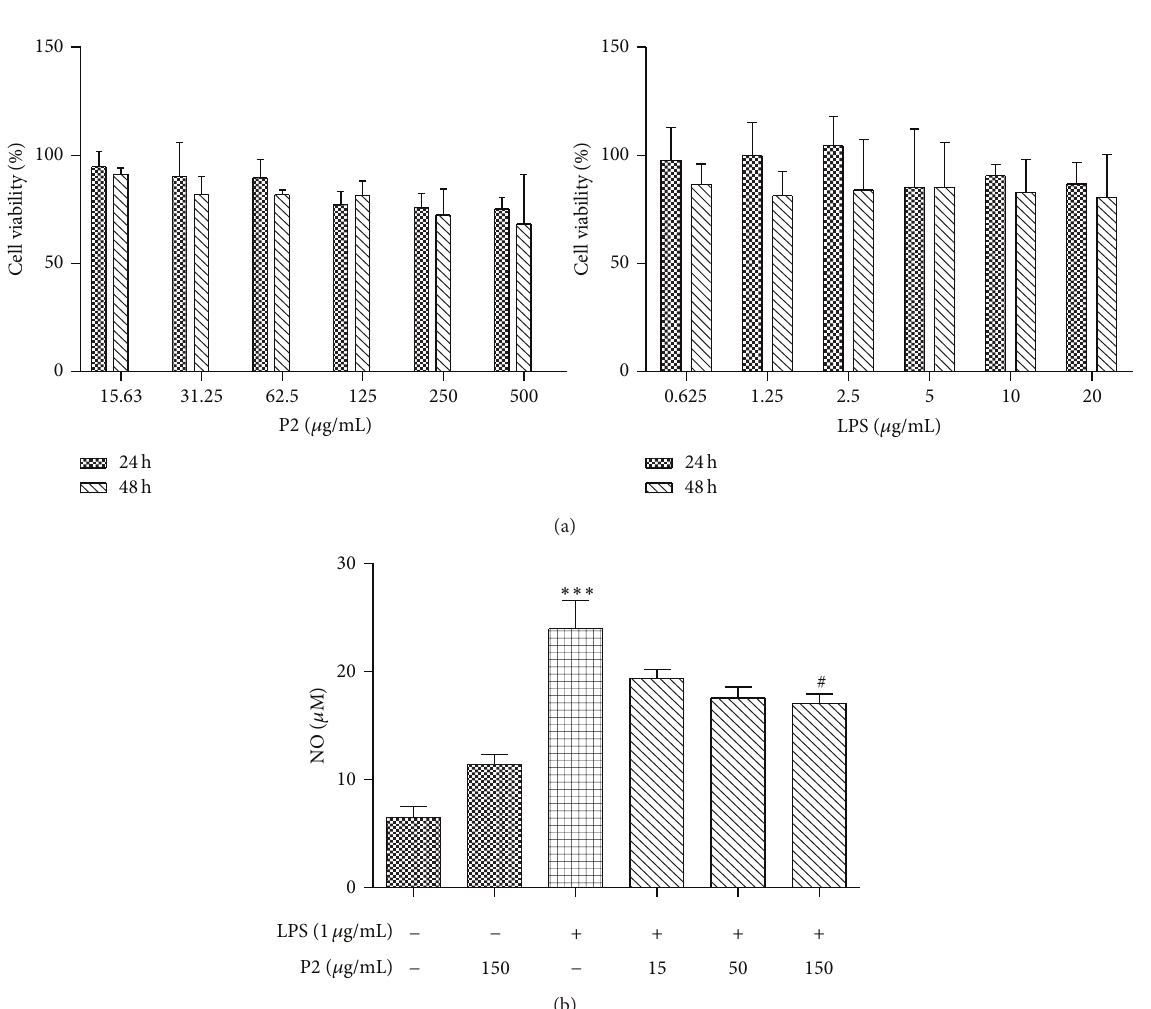
Figure 1: (a) Effects of P2 and LPS on the cell viability of RAW264.7 cells. RAW264.7 cells were treated by P2 and LPS at different concentrations for 24 h and 48 h. Cell viability was determined by MTT assay. The results are representative of three independent experiments and expressed as mean ± SD. Differences were defined as significant at 𝑃 < 0.05 . (b) Effects of P2 on NO production in LPS-stimulated RAW264.7 cells. Cells were stimulated with LPS for 2 h followed by treatment with P2 (15–150 𝜇 g/mL) for 48 h. Nitrite in the medium was measured using Griess reagent. ∗∗∗ 𝑃 < 0.001 compared with NC (negative control); # 𝑃 < 0.05 compared with LPS-treatment only. The results are representative of three independent experiments and expressed as mean ± SD. Differences were defined as significant at 𝑃 < 0.05